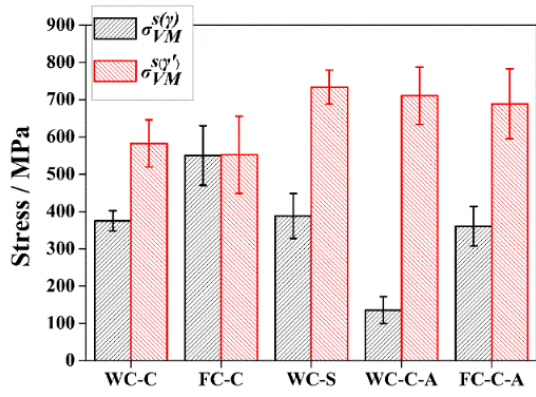
Figure 8. The Von-Mises stress of the γ / γ ′ phase for different heat treatment modes and sample shapes.